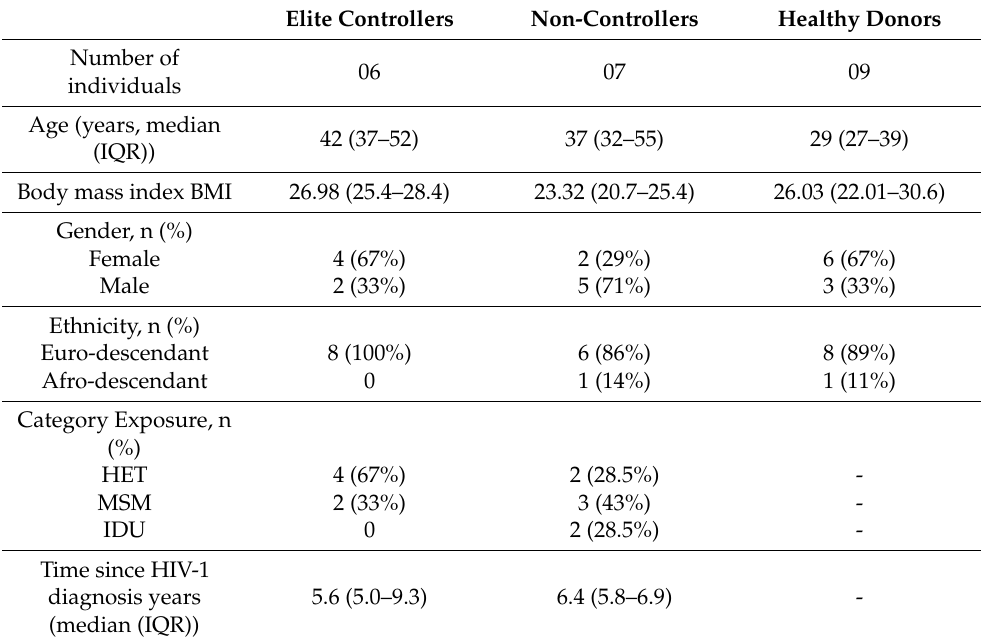
Table 1. Demographic and clinical characteristics of